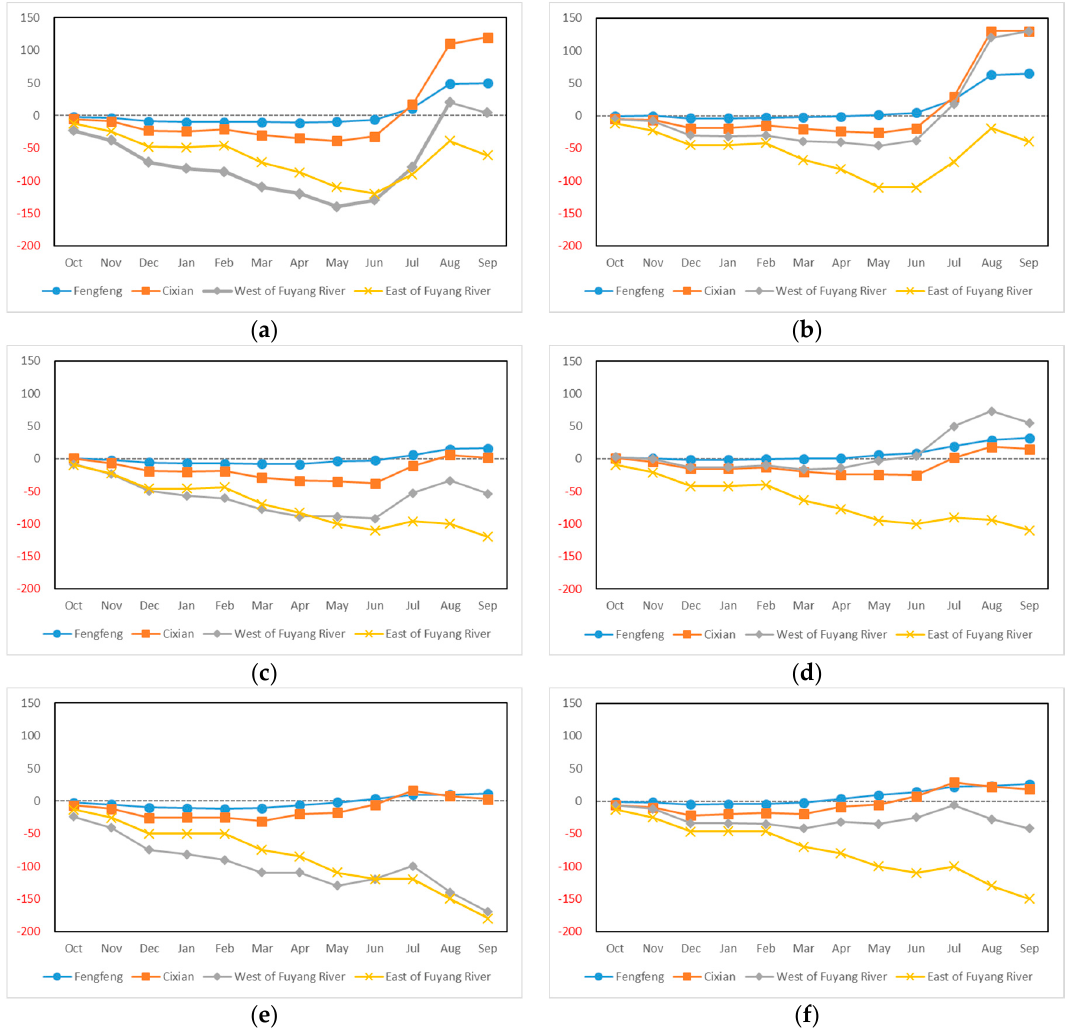
Figure 5. Storage changes of groundwater in different scenarios (Unit 10 6 m 3 ). ( a ) Wet year, without the SNWD Project; ( b ) Wet year, with the SNWD Project; ( c ) Normal year, without the SNWD Project; ( d ) Normal year, with the SNWD Project; ( e ) Dry year, without the SNWD Project; ( f ) Dry year, with the SNWD Project .